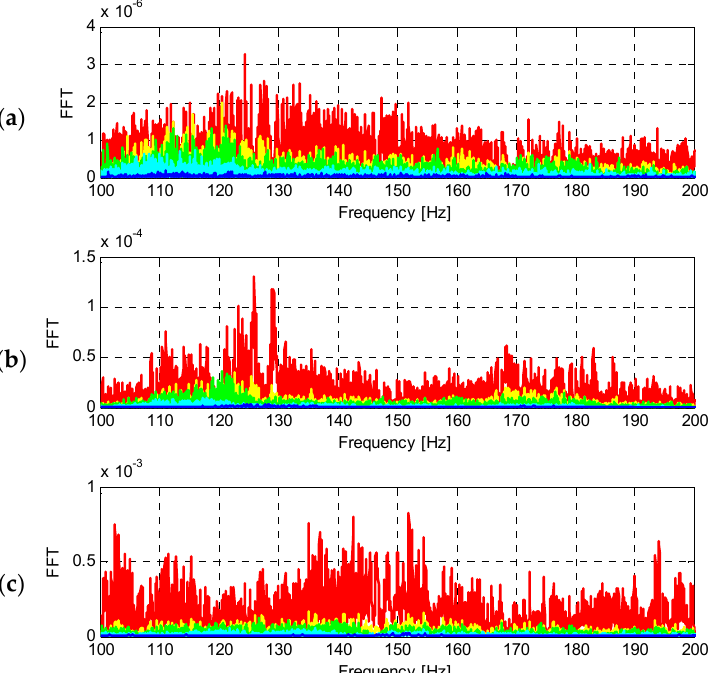
Figure 30. Power spectral density of the results from the additional accelerometers. Material: Sa 3; Isotropic pressure 100 kPa; Frequency spectrum 100–220 Hz; Excitation (torque) amplitude: ( a ) 0.5 V, ( b ) 2 V, ( c ) 4 V (– the top sensor, S1, – the second sensor from the top, S2, – the third sensor from the top, S3, – the fourth sensor from the top, S4, – the bottom sensor,